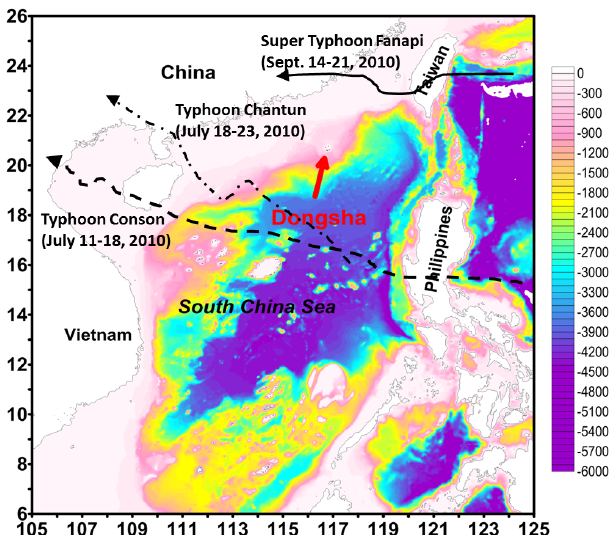
Fig. 1. Map of the South China Sea and sampling location of Dong- sha Island. The arrow curves denote the pathways of three typhoons that passed over the northern or southern regions of Dongsha during the sampling